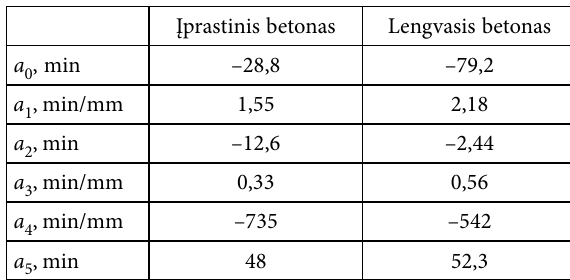
Table 1. Coefficients for evaluation of fire resistance